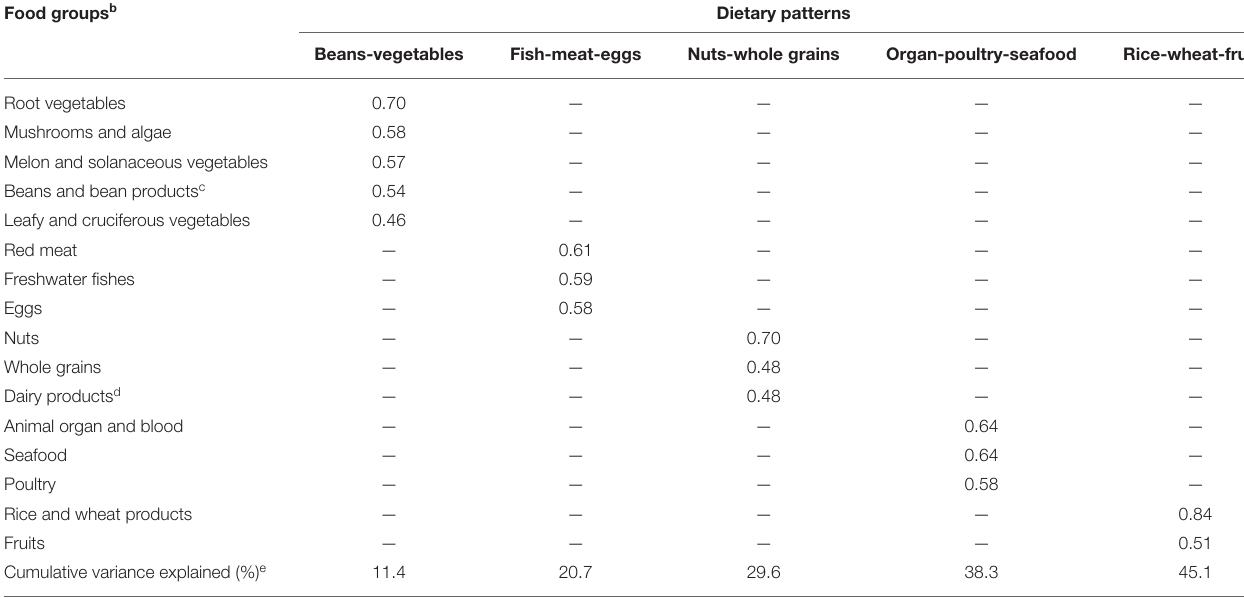
TABLE 1 | Factor loading matrix for dietary patterns identified by principal component analysis ( n = 3,334) a . Food groups b